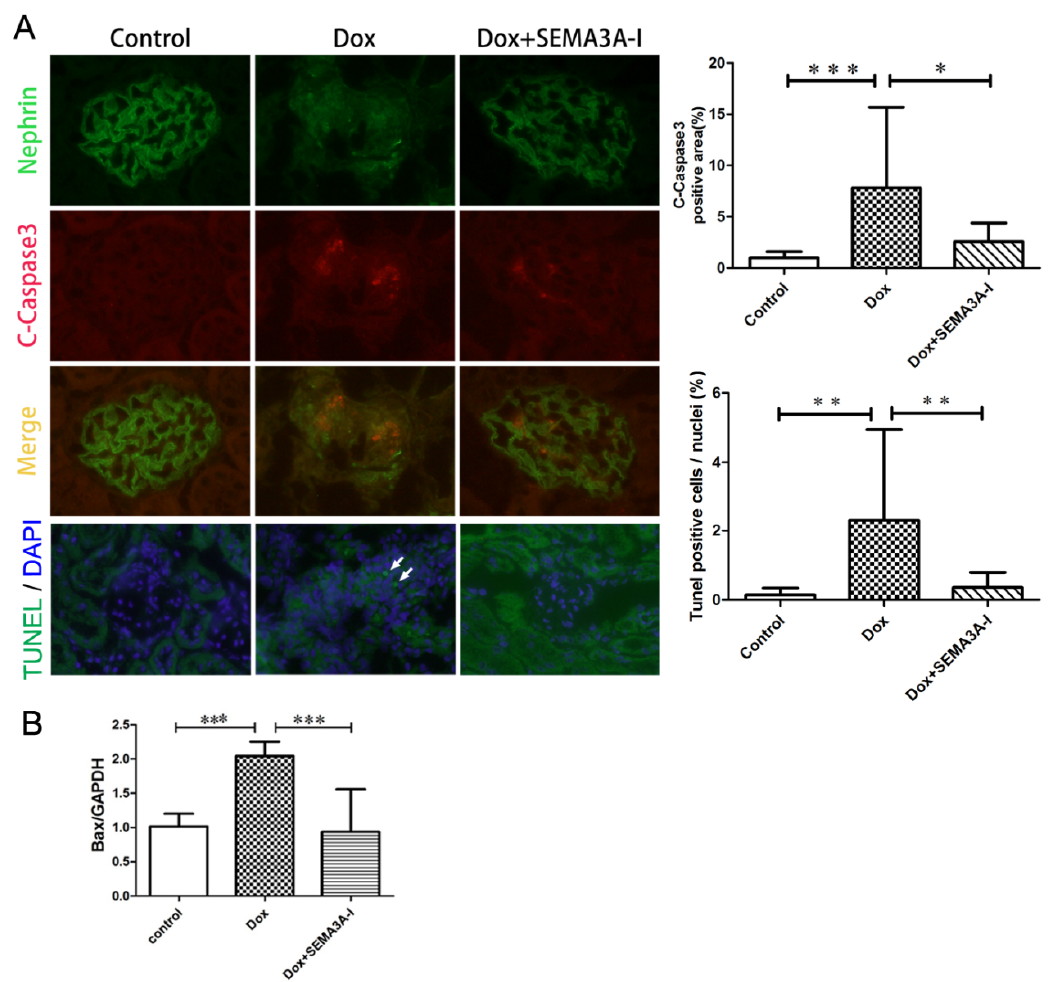
Figure 3. SEMA3A-inhibitor protected from Doxorubicin-induced podocyte apoptosis. ( A ) Dual immunofluorescence staining of cleaved-caspase3 (C-Caspase3) (red) and nephrin (green) in mouse glomeruli from the control, Dox, and Dox + SEMA3A-I groups at the time point of 2 weeks after Dox injection, showing the increase of C-Caspase3-positive podocytes in the Dox group, and fewer C-Caspase3-positive cells in the Dox + SEMA3A-I group. Images of immunofluorescent staining of TdT-mediated dUTP Nick-End Labeling (TUNEL, green) and 4′,6′-diamidino-2-phenylindole (DAPI, blue) in the control, Dox, and Dox + SEMA3A-I groups (Lowest panel) show that TUNEL-positive cells were detected in the Dox group (white arrows), while almost no TUNEL-positive cells were detectable